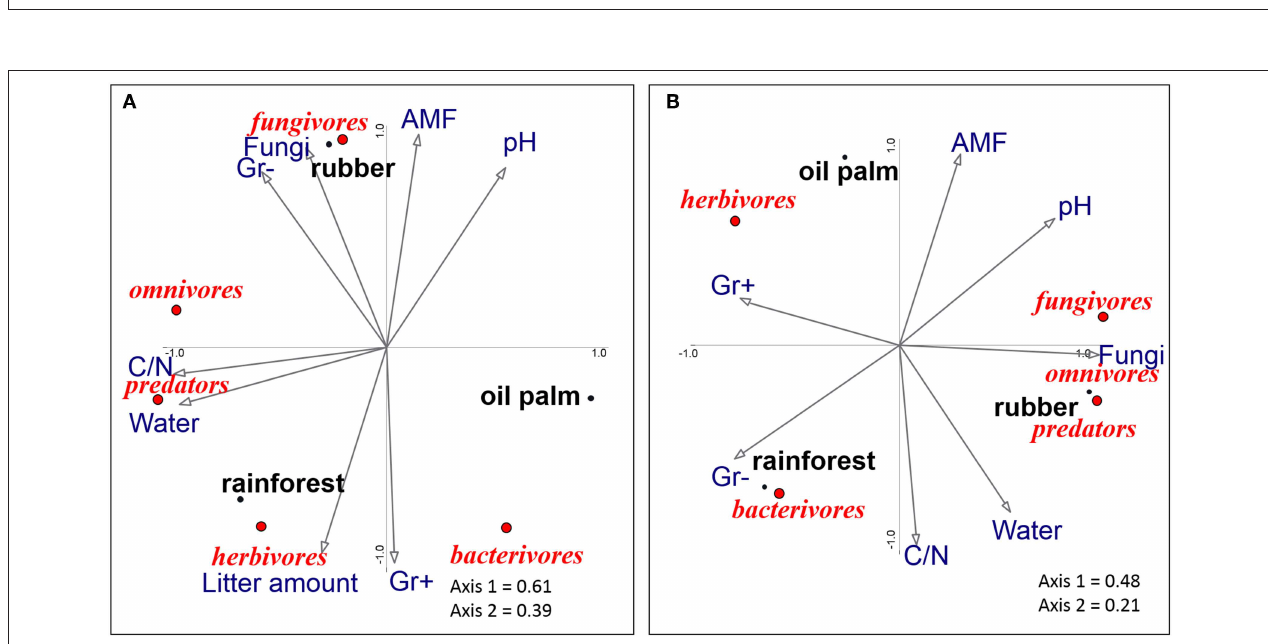
FIGURE 1 | Variations in relative abundance of trophic groups of nematodes (percentages of total) with land use in litter (top row) and in soil (bottom row), means ± SD; F, Rainforest; O, oil palm plantation; R, rubber plantation; Fungi, fungivores; Bact, bacterivores; Pred, predators; Herb, herbivores; Omni, omnivores; Unident, unidentified.